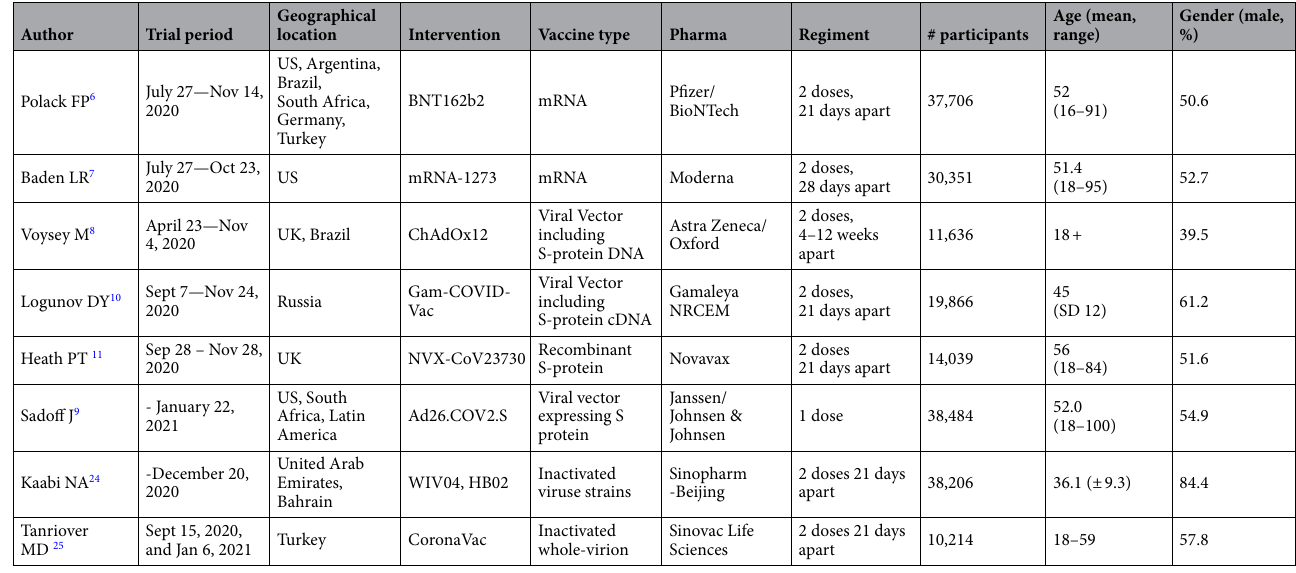
Table 1. Characteristics of included